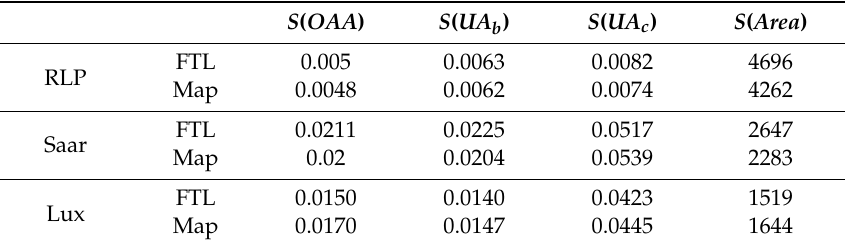
Table 14. Standard error for the mappings based on Landsat 8 and Sentinel-2 (NDVI) for each subregion. S ( Area ) reports the standard error for estimated area in hectares, S ( OAA ) for overall accuracy, S ( UA ) for the user’s and S ( PA ) for the producer’s accuracy; the subscript b stands for broadleaved, subscript c for coniferous